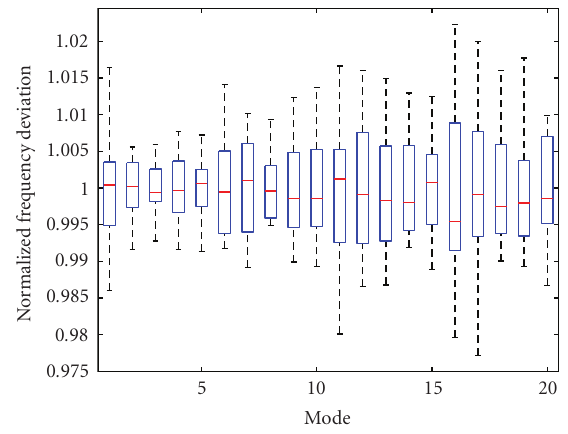
Figure 4: Airfoil frequency variation.